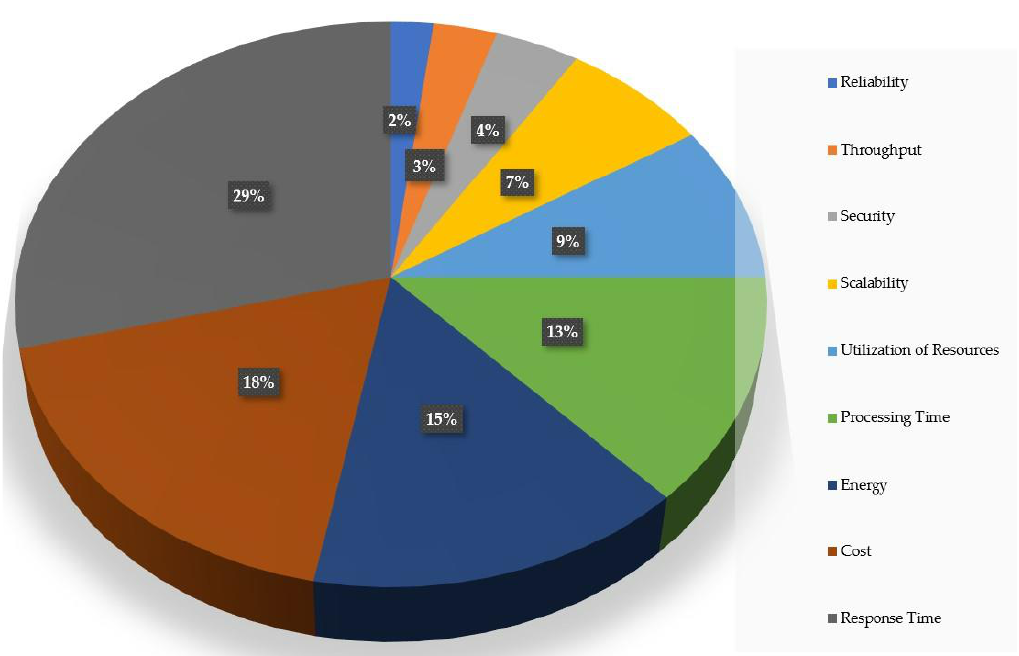
Figure 4. Percentage-wise evaluation parameters for load balancing in fog computing.